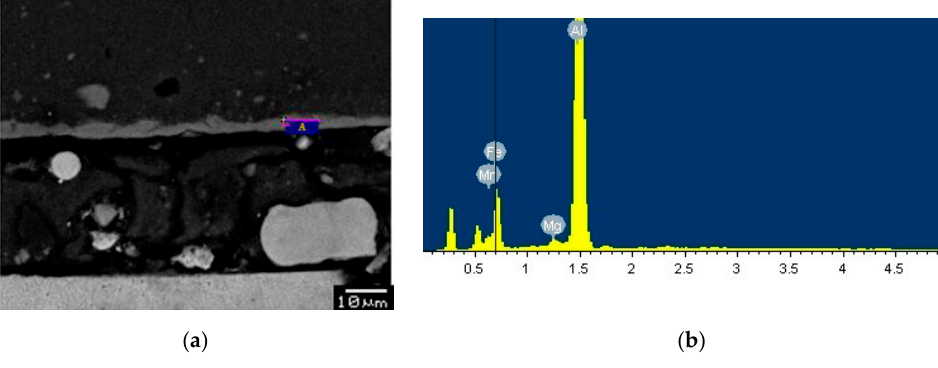
Figure 18. Graphs of line scanning in electron dispersive X-ray spectroscopy (EDS) analysis: ( a ) position of line scanning, ( b ) Al distribution, ( c ) Fe distribution, ( d ) C distribution and ( e ) Mg distribution.